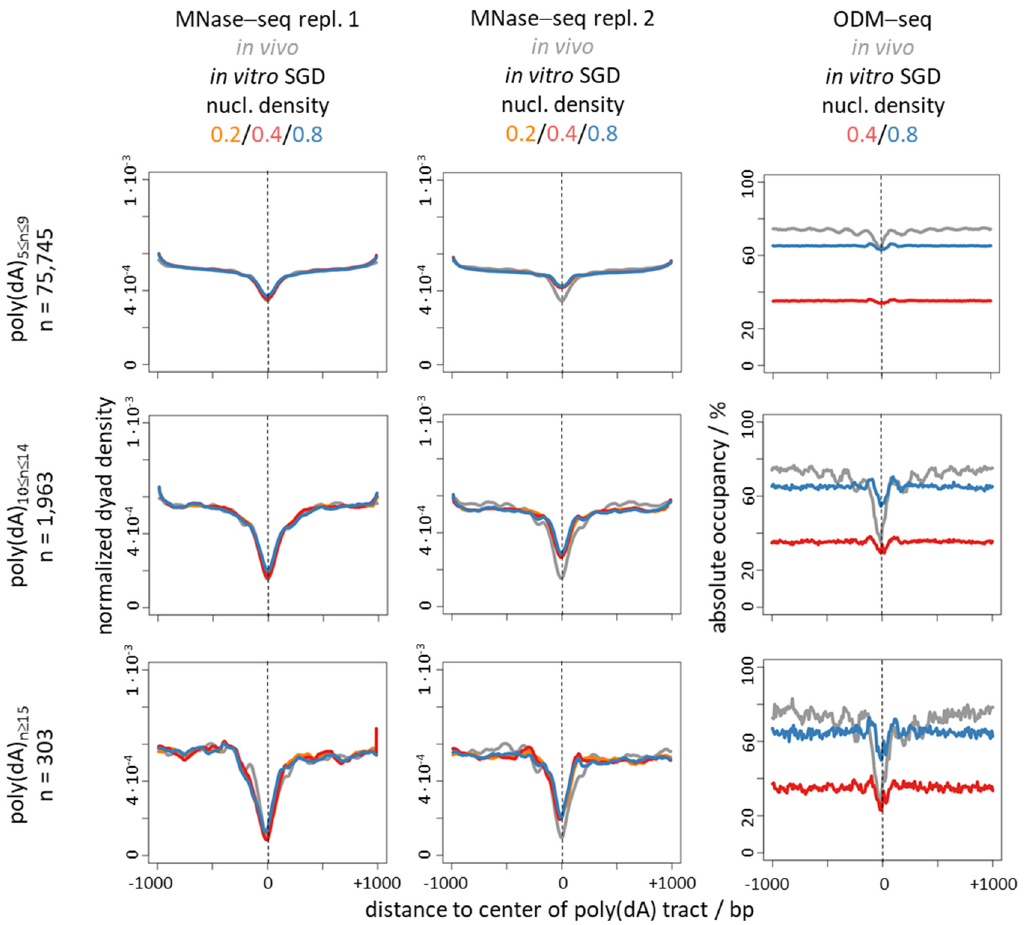
Figure 3. Nucleosome depletion over poly(dA) tracts scales with tract length and seems similar in extent in vitro versus in vivo if monitored by MNase-seq but not by ODM-seq. Composite plots of same data as in Figure 2 (MNase-seq repl. 1 and ODM-seq) plus an additional MNase-seq data replicate (MNase-seq repl. 2) for in vitro SGD chromatin with nucleosome density 0.2/0.4/0.8 from [33] (GSM4175803/GSM4175804/GSM4175805, respectively). Data are aligned at all poly(dA) tracts in the S. cerevisiae genome subdivided into the indicated tract length ranges. Number (n) of instances is indicated. Strand orientation was taken into account by flipping the orientation for poly(dA) tracts on the opposite strand. Vertical dashed lines mark the alignment